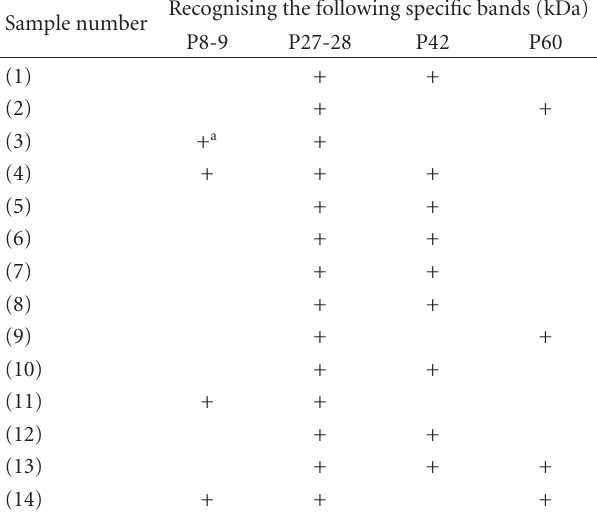
Table 1: Frequencies of F. hepatica various antigenic fractions react- ing with serum from fourteen asymptomatic adults in Port-au- Prince,